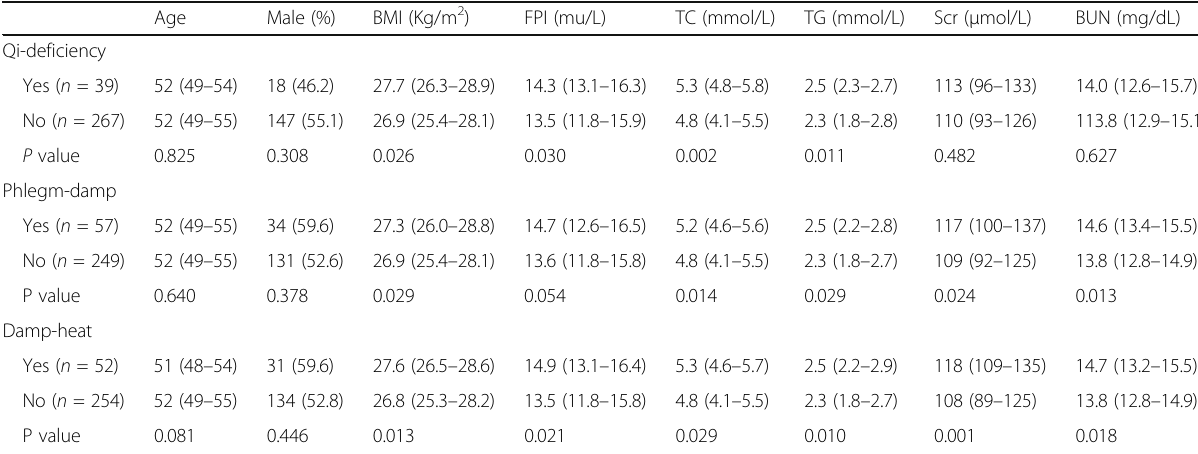
Table 1 Patients ’ characteristics